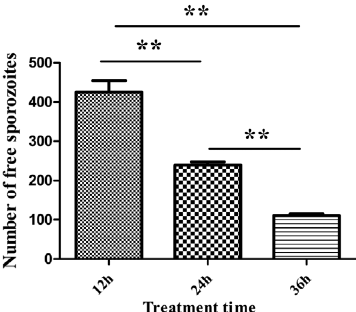
Figure 2. Parasite development is essential for NO-induced egress . PCKs were infected with sporozoites for 12, 24, or 36 h and then incubated with 40 mM SNP for 30 min. The number of free sporozoites was analyzed by fl ow cytometry. Data are means ± SEM of six replicates, representing three independent experiments. * p < 0.05; ** p <